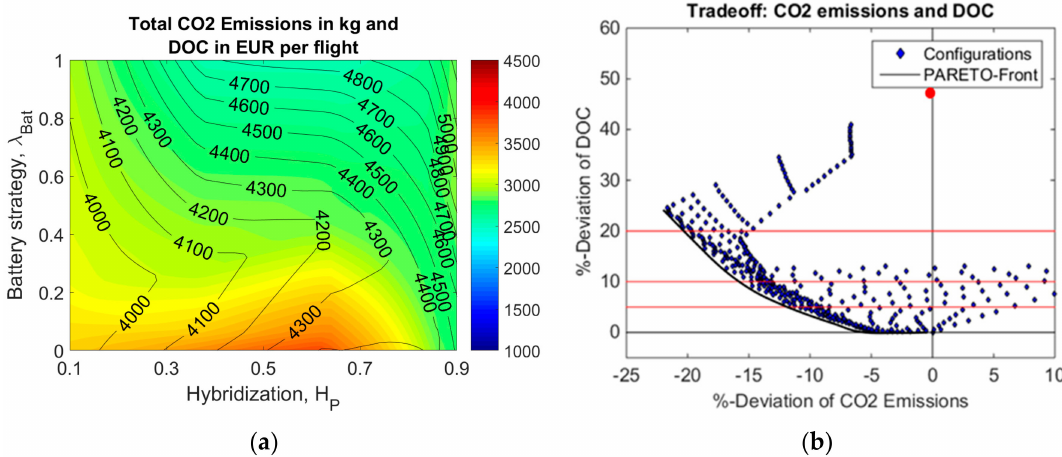
Figure 8. Total CO 2 emissions per flight in case of Battery 2 (0.65 kWh/kg, 1 kW/kg): ( a ) Total CO 2 emissions (heat map) and DOC per flight (contour lines); ( b ) PARETO-front for optimal